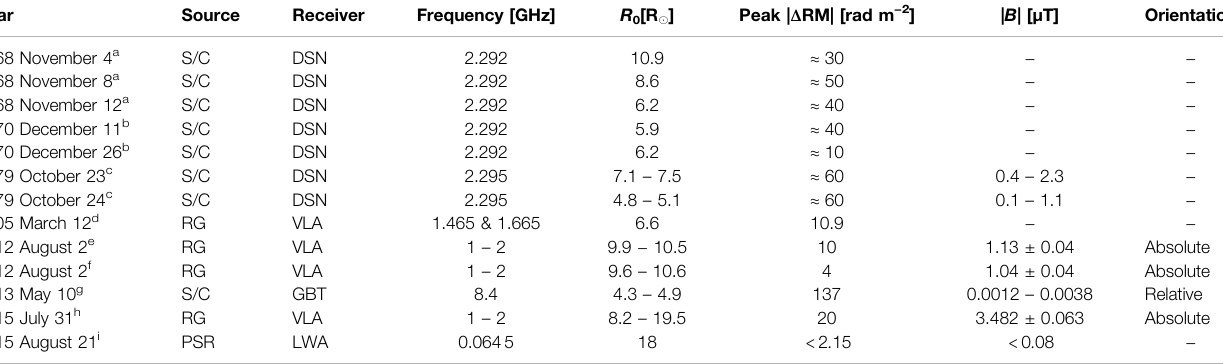
TABLE 3 | Results from FR studies of coronal mass ejections. S/C, RG, and PSR are spacecraft, radio galaxy, and pulsar background radio sources,